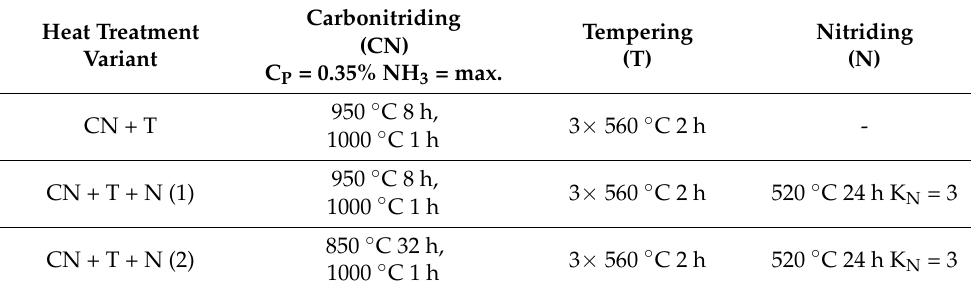
Table 5. Heat treatment parameters for the experimental forging dies.